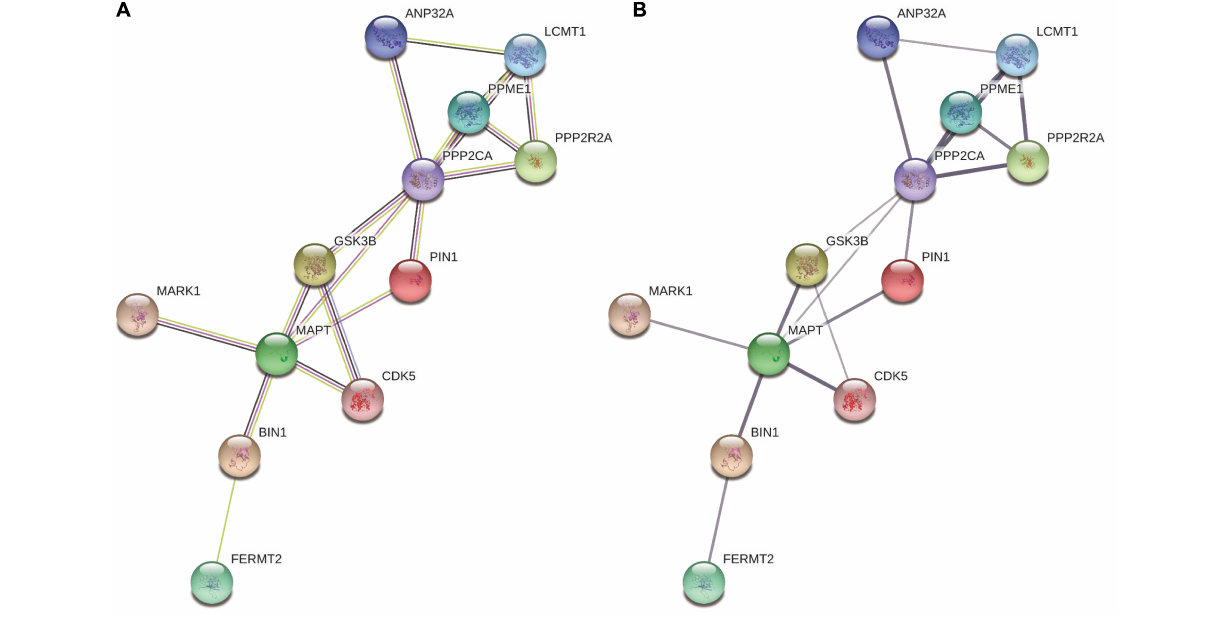
Frontiers in Aging Neuroscience |